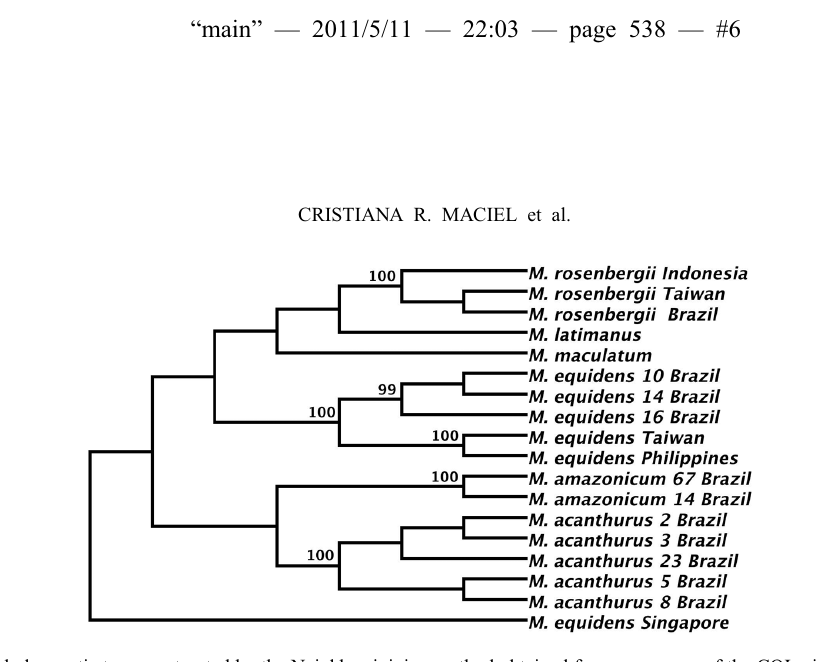
Fig. 2 – Unrooted phylogenetic tree constructed by the Neighbor-joining method obtained from sequences of the COI mitochondrial gene. The values at the nodes are bootstrap percentages for 1000 pseudoreplicates.